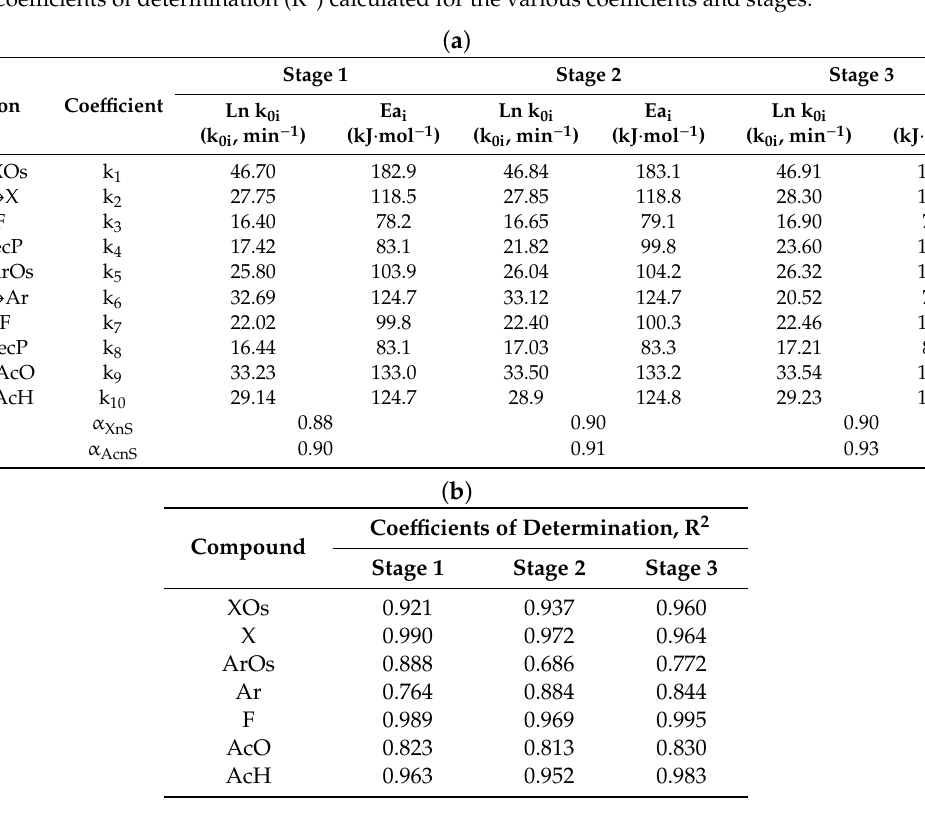
Table 6. ( a ) Results achieved for the pre-exponential factors (k 0i ) and activation energies (Ea i ) of the coe ffi cients involved in the kinetic models, and for the susceptible fractions of xylan and acetyl groups. ( b ) Coe ffi cients of determination (R 2 ) calculated for the various coe ffi cients and